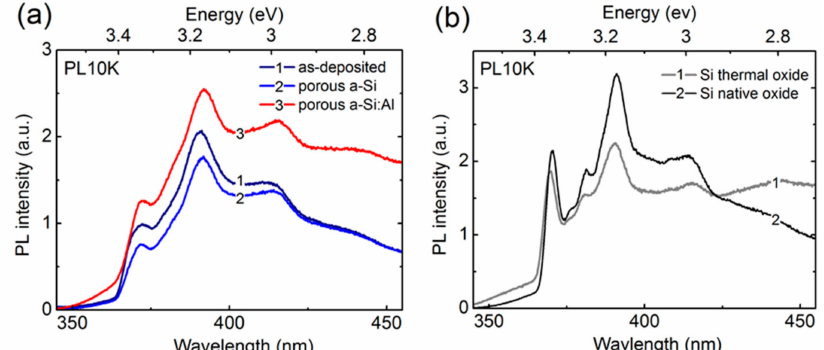
Figure 7. ( a ) Dynamic PL spectra obtained at 10 K from as-deposited a-Si:Al nanostructure, nanoporous a-Si (one-week exposure to air), and porous a-Si:Al (34-week exposure to air), ( b ) monocrystalline Si with 100 nm-thick thermal oxide and native oxide,